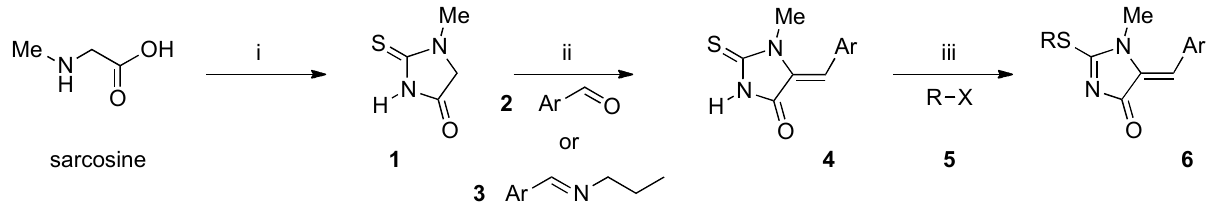
SCN (3 equiv.), 140 °C, 19 h. (ii) Method A: 2 (1 4